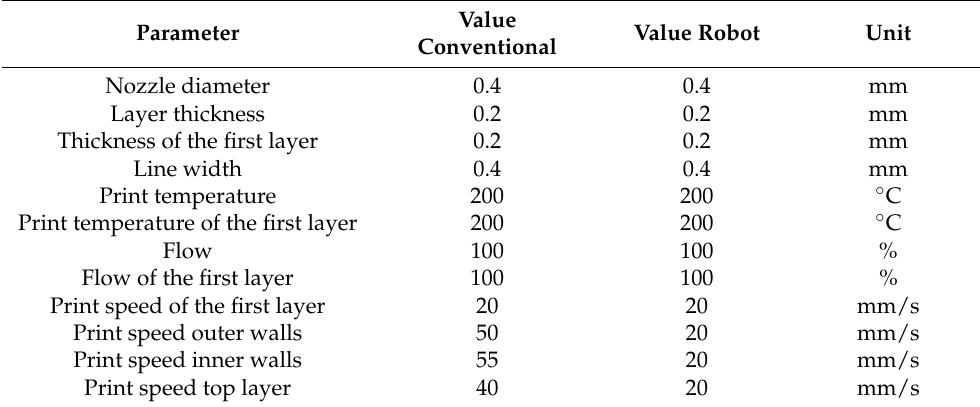
Table 1. General manufacturing parameter of the test specimen for both test